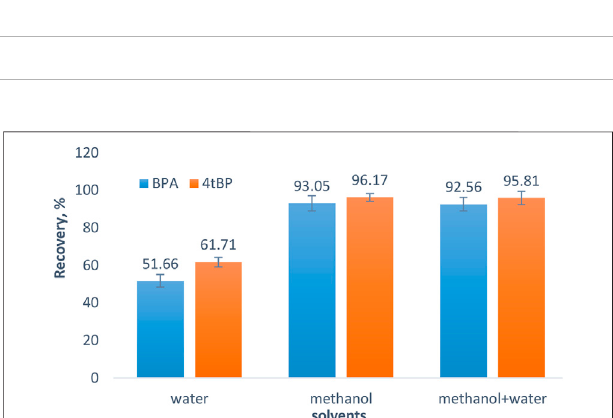
FIGURE 6 | Effect of eluents on the extraction of BPA and 4- tert -BP. Conditions: Adsorption at pH 7, adsorbent dose 0.2 g, time 80 min at room temperature, and concentration of analyte 25 µgml − 1 . Desorption water, methanol, and mixture of water methanol in 1:1 ratio as solvents, and volume of solvent 5